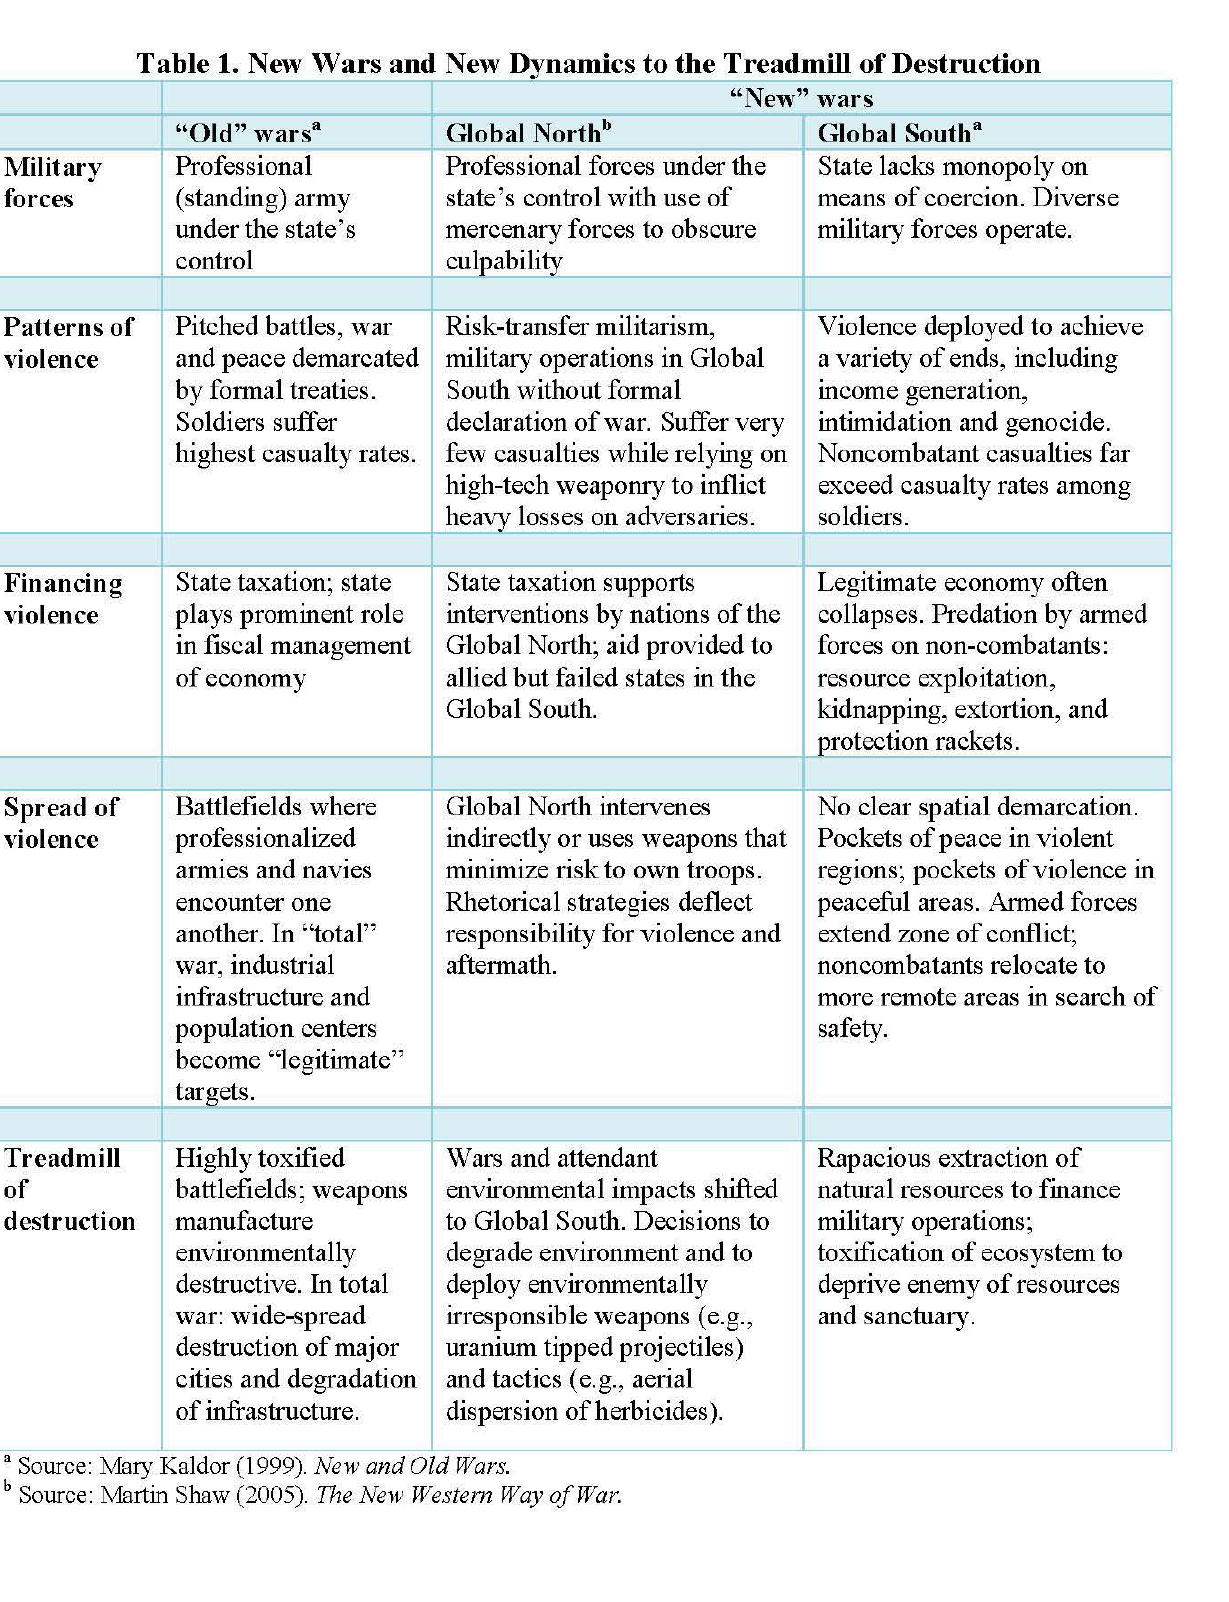
Table 1. New Wars and New Dynamics to the